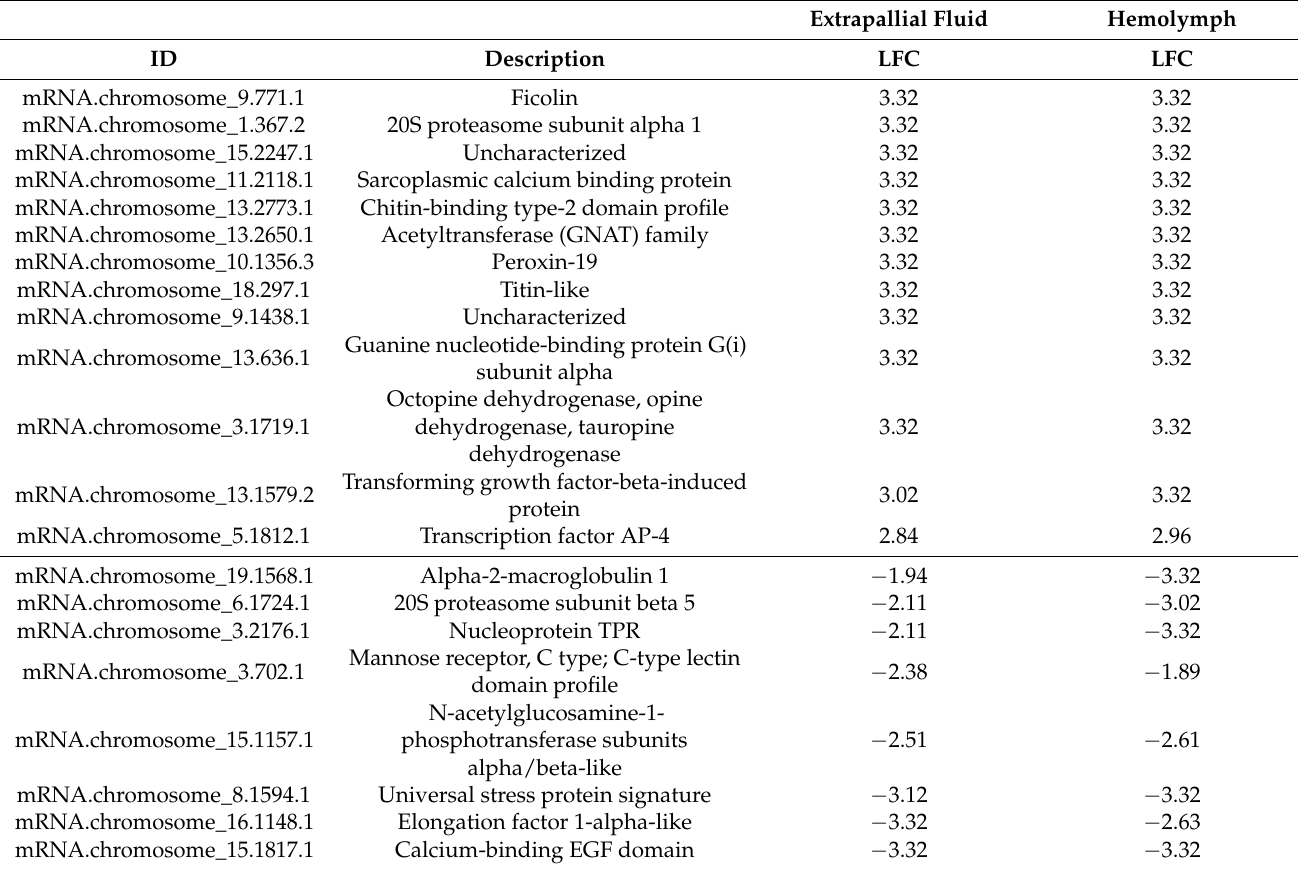
Table 2. Genes showing differential expression at the protein level in both EPF and hemolymph from clams in OA vs. clams in control conditions. Expression level corresponds to the OA treatment. Log2foldchange (LFC) is given. The table is divided into subsections by proteins, with similar trends in both fluids and then opposing